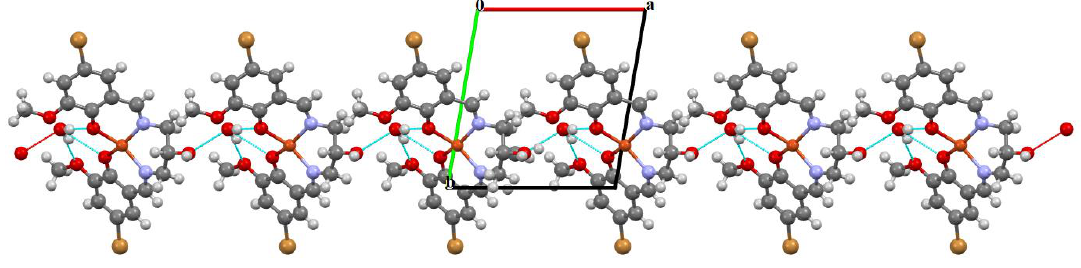
Figure 4. Part of the crystal structure of complex 1 showing O–H ··· O hydrogen bonds and formation of the 1D chain along the a direction.